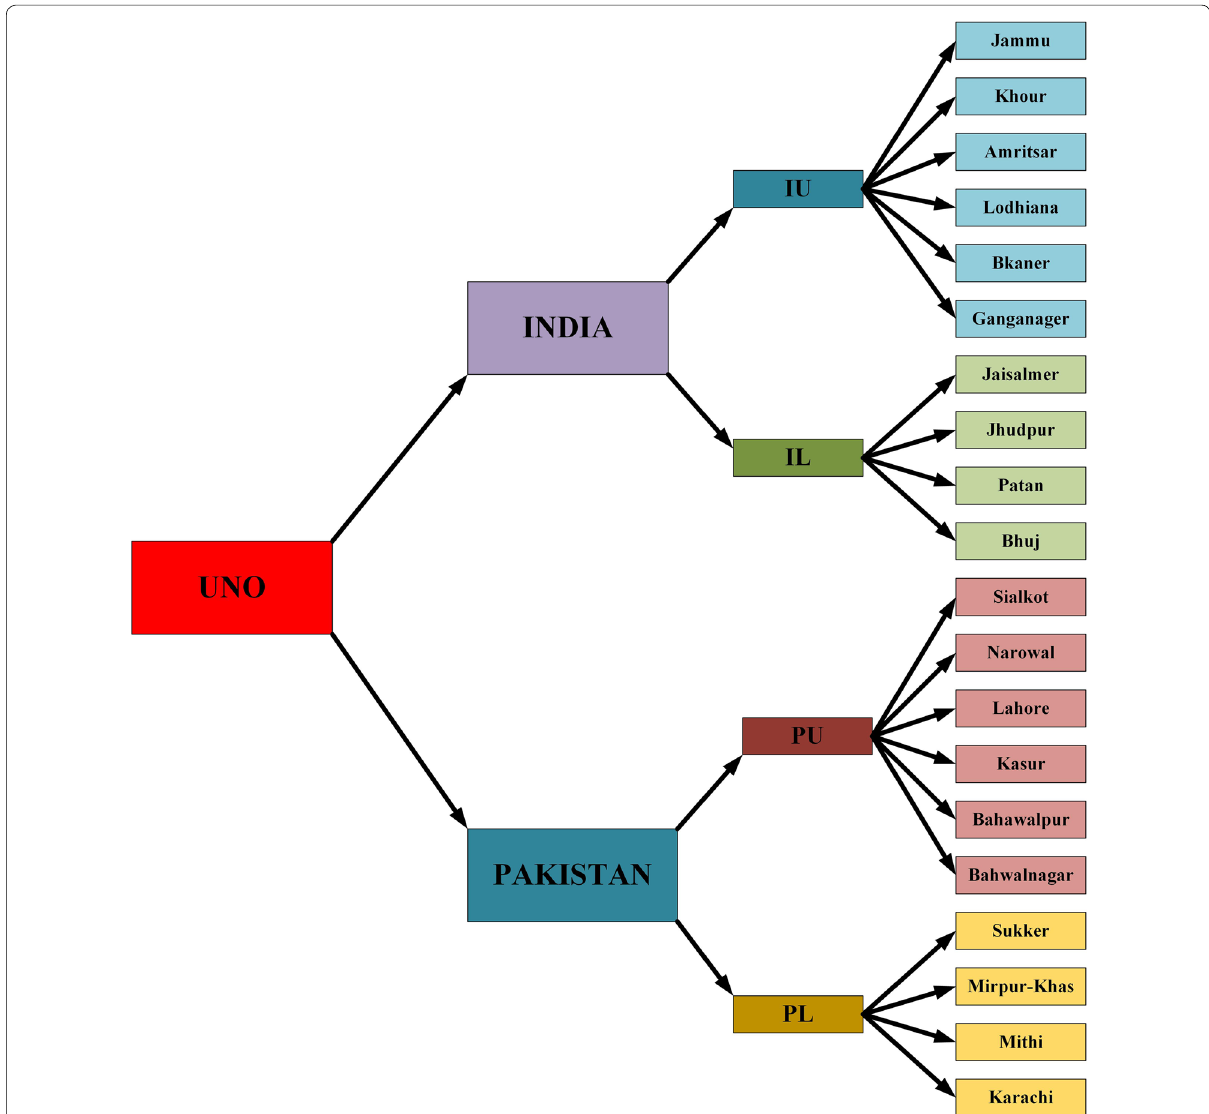
Fig. 8 Proposed organogram of polluter Pay Principle Project (U/L